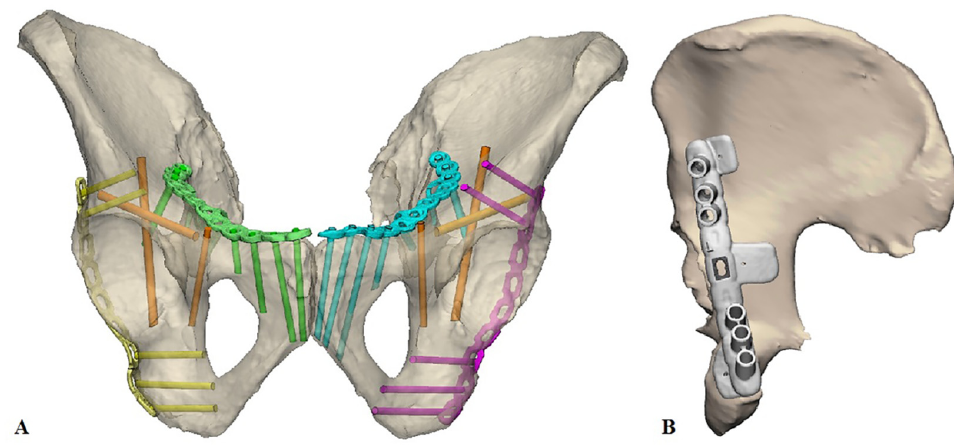
Figure 1. 3D preoperative planning. ( A ): Overview of the pre-planned screw directions and the pre-contoured implants on the pelvis. The cylinders represent the pre-planned screw directions of the in-plate screws (yellow, green, blue, and purple) and in orange the infra-acetabular and column screws. ( B ): Pre-contoured posterior implant and the surgical guide with the bone extensions.